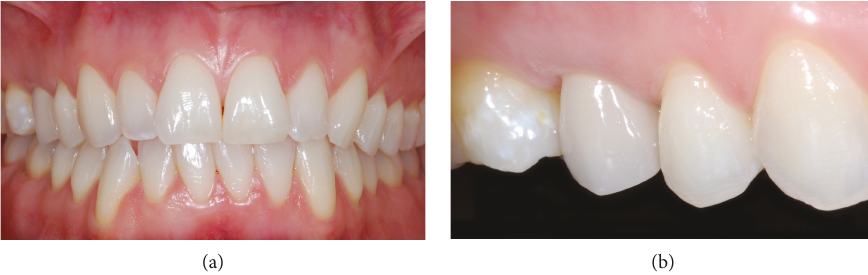
Figure 4: Postoperative intraoral frontal (a) and lateral (b) views showing good integration of the new veneered-zirconia crown on tooth 1.5.